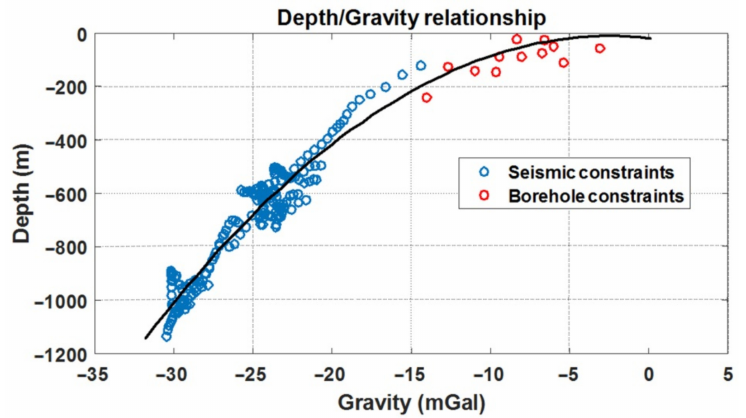
Figure 4. Depth–gravity plot obtained using a constraint set relative to the top of the Meso-Cenozoic carbonate rocks, including the deeper seismic horizon and borehole data. The black line is a second- degree polynomial curve approximating the distribution of the constraint points.